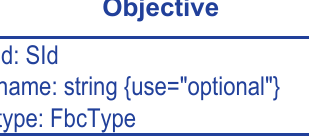
Figure 5: A UML representation of the Flux Balance Constraints package Objective class. For a complete description see Figure 1 as well as Section 1.4 for conventions related to this figure.